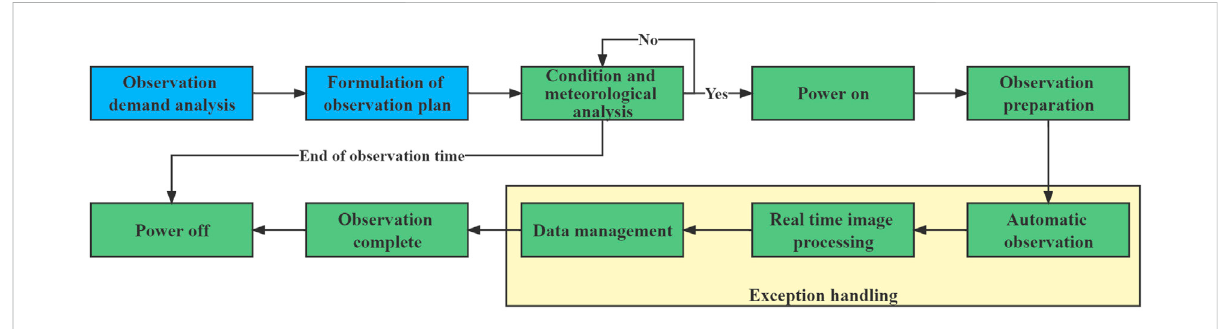
FIGURE 4 Observation process of the whole system.